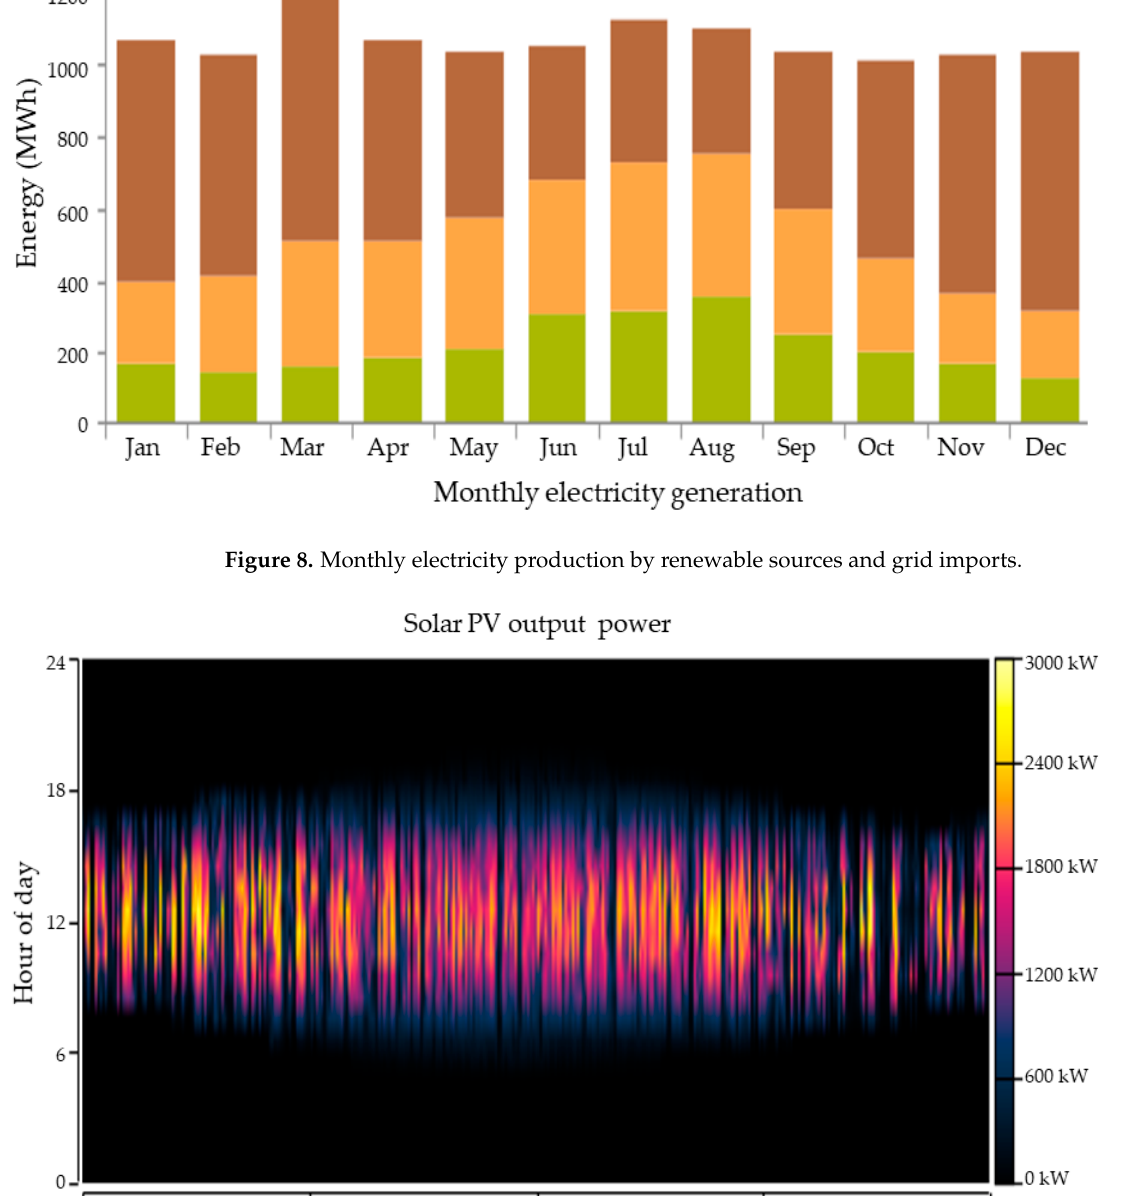
Table 4. Description of the solar PV system model.